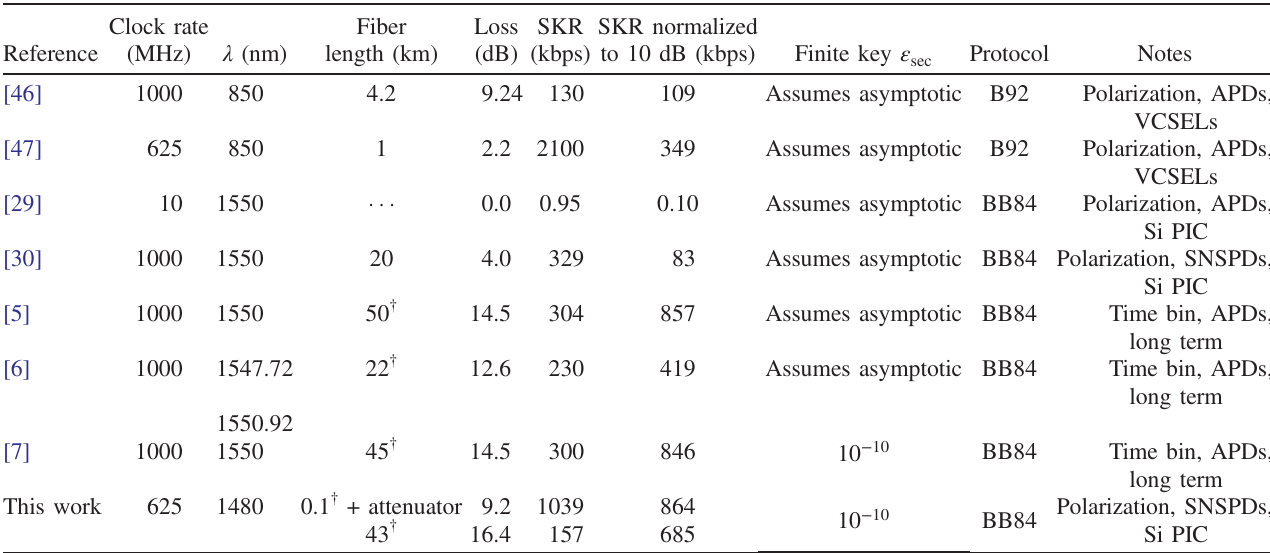
TABLE I. Comparison of high-rate polarization-based QKD experiments and other high-rate discrete-variable QKD field tests.